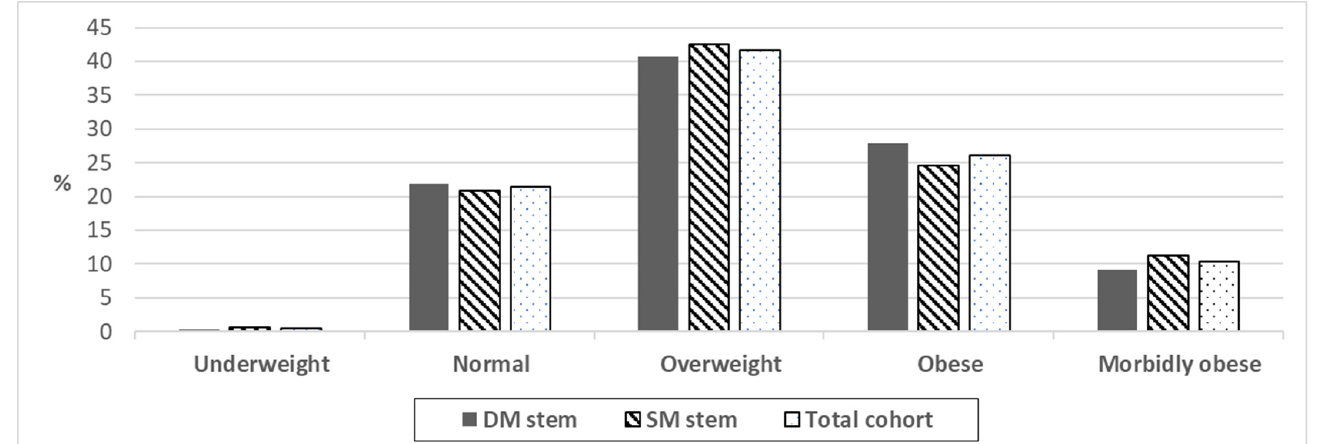
Figure 1. BMI subgroups distribution between the groups and of the total cohort. DM–dual-modular stem, SM–single-modular stem.